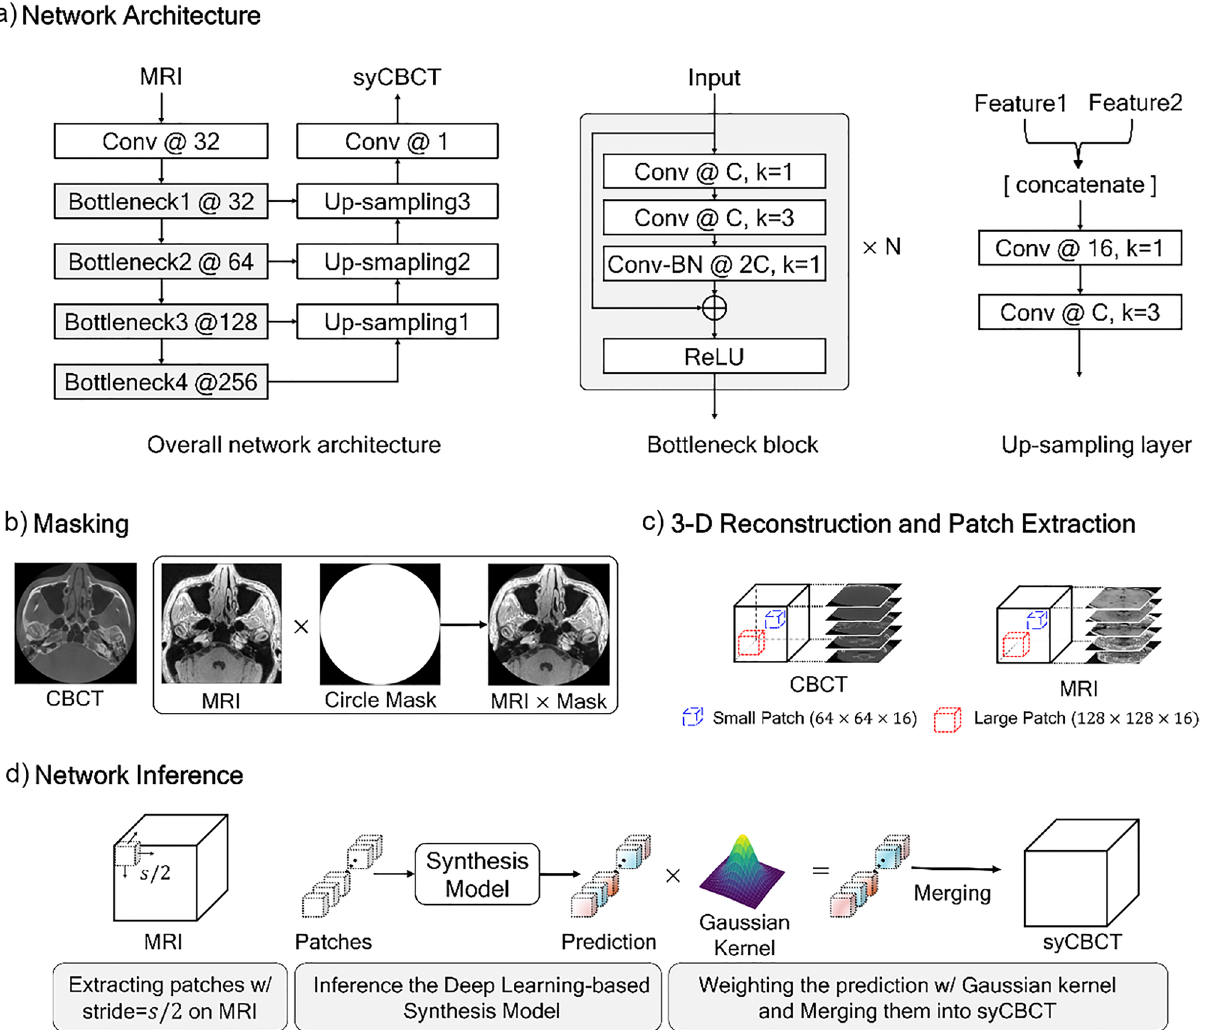
Figure 1. The overall network training and inference process. ( a ) Our network architecture. Conv denotes the kernel series of [Convolution-Batch Normalization (BN) -Rectified Liner Unit (ReLU)], N indicates the number of repeated bottleneck blocks, the number after the symbol @ represents the number of kernels, and k denotes the kernel size. ( b ) The MRI and CBCT are multiplied by a circle mask at the pixel level. ( c ) Large or small patches are extracted from the 3-dimensional reconstructed image. ( d ) An input MRI is partitioned into sub- patches, and then predictions of the trained network are weighted by the Gaussian Accuracy assessment and clinical validation. Three‑dimensional model surface deviation. A three- dimensional maxillofacial model was generated in the STL format based on both original CBCT and syCBCT. The two models were superimposed for measurement using Geomagic Control X (3D Systems, Cary, NC, USA). Then, the overall surface deviation was acquired (Fig. 2a) for both large and small patches based on syCBCT. The surface deviation of syCBCT was also obtained for anatomical regions, maxilla, and mandible in the axial and anterior–posterior coronal planes (Fig. 2b). The reference planes were determined by following a previ- ous study 19 . The axial plane was determined by the cement o-enamel junction of the upper and lower teeth. Anatomical landmarks, including mental foramen (anterior) and mandibular foramen (posterior), were used to determine the coronal plane. All measured deviation values were obtained in root mean square (RMS, mm). Expert image quality evaluation. Two radiologists with more than 10 years of experience conducted a sub- jective evaluation using the modified version of the clinical image evaluation chart of CBCT provided by the Korean Academy of Oral and Maxillofacial Radiology (Table 1). The clinical image evaluation chart comprises 4 sections: artifact, noise, resolution, and overall image. In the artifact, noise, and resolution sections, the evalua- tor graded image series as poor, moderate, or good. For overall grade, the possible outcomes were: no diagnostic value, poor, moderate, or good.